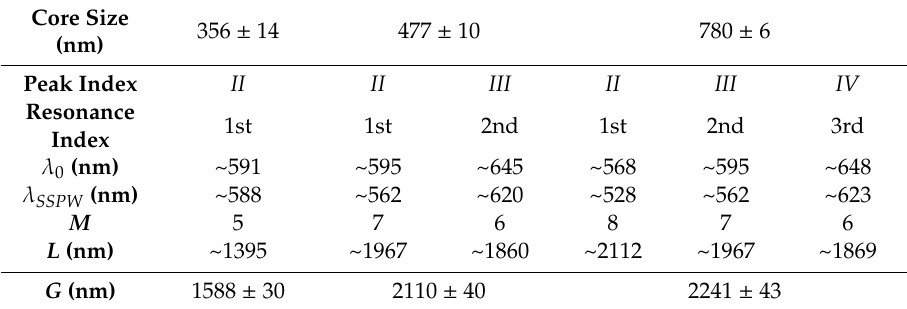
Table 2. Summary of concepts, numerical estimates, and measurements discussed in Section